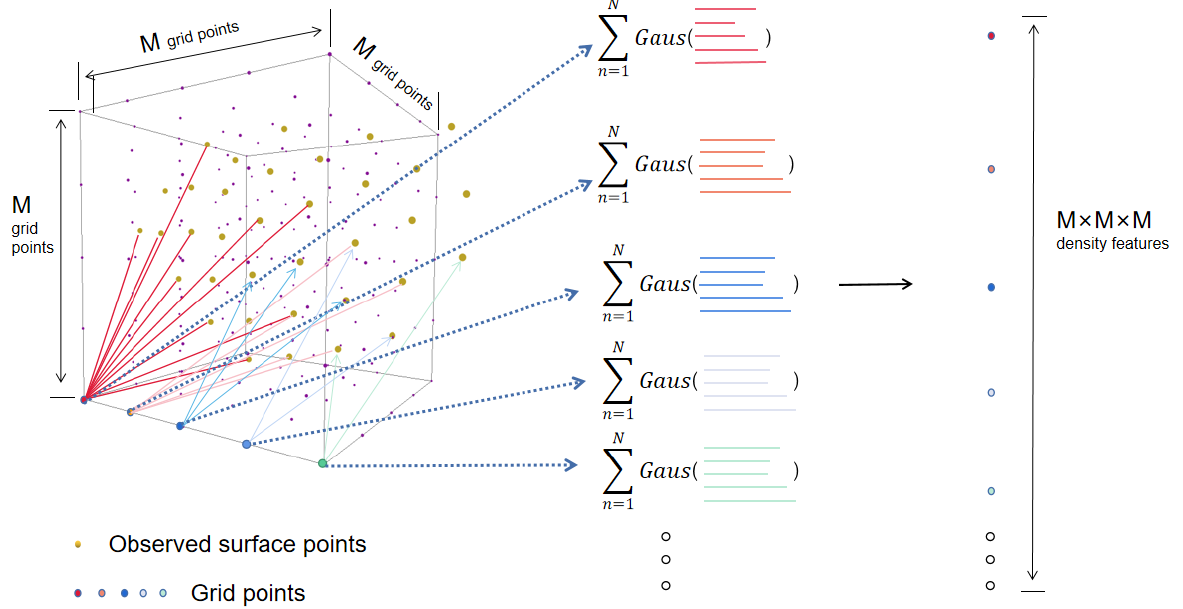
Figure 3. The density feature on each grid point is computed by summing up all the contributions of N observed points within this local region (denoted in gold); the overall representation for this region is fixed in size as M 3 , and is invariant to order permutation or the length of input